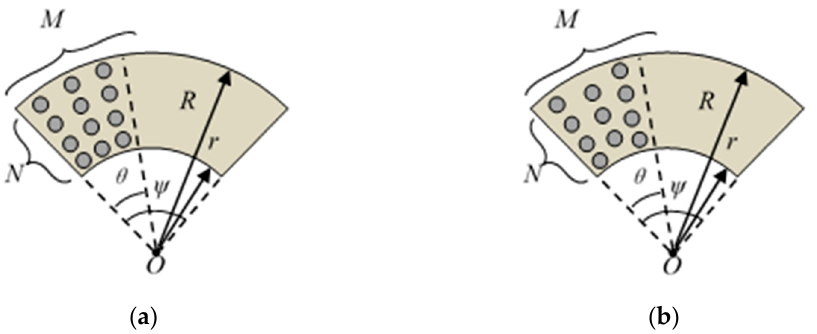
Figure 2. Geometrical parameters of textures in ( a ) radiation array and ( b ) staggered radiation array.